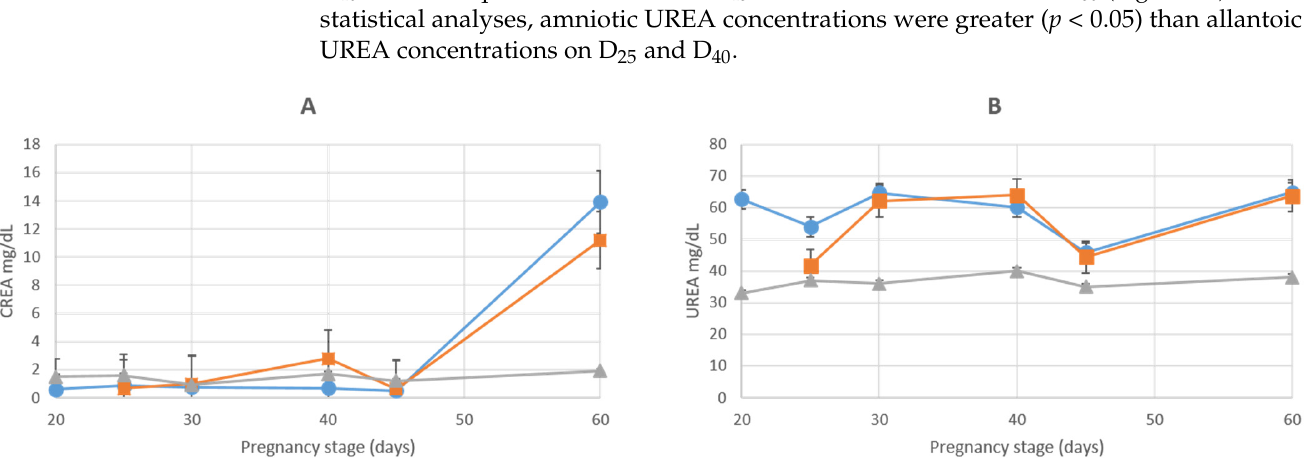
Figure 7. Graphic representation of CREA ( A ) and UREA ( B ) concentrations during pregnancy in maternal serum (marked with (cid:78) ), amniotic fluid (marked with • ) and allantoic fluid (marked with maternal serum (marked with ▲ ), amniotic fl uid (marked with ● ) and allantoic fl uid (marked with (cid:4) ). Values are indicated as mean ± ■ ). Values are indicated as mean ± SE.